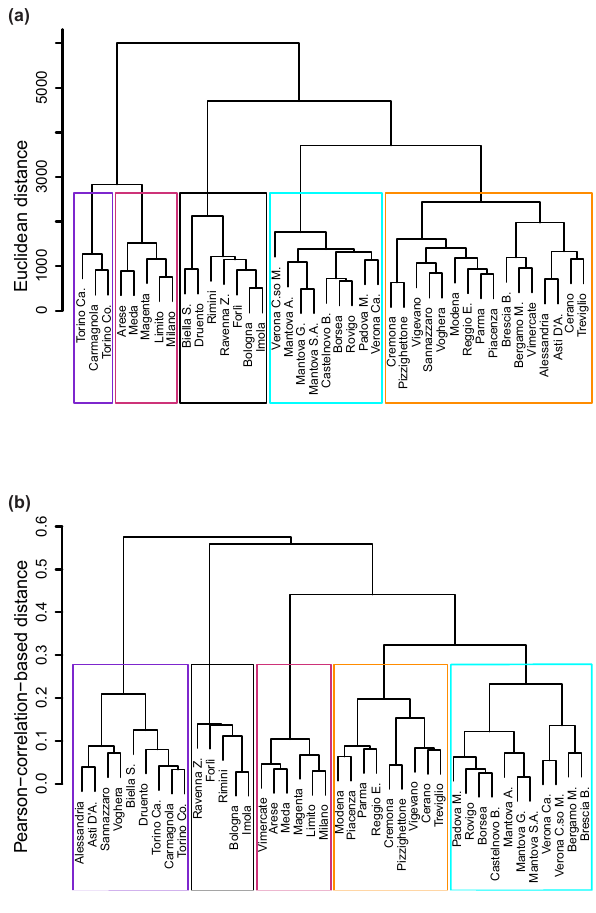
Figure 5. Results of cluster analysis on daily PM 10 data using Euclidean distance (a) and Pearson-correlation-based distance (b) . Coloured boxes indicate clusters; monitoring sites’ positions can be found in Fig.